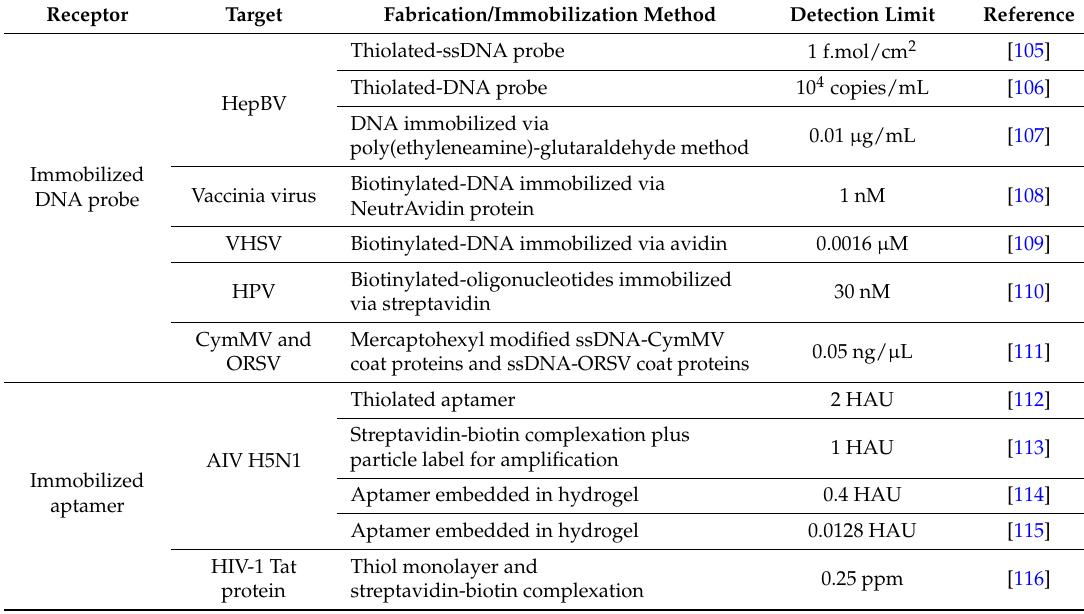
The selected examples of the DNA and the aptamers as receptors for QCM-based viral